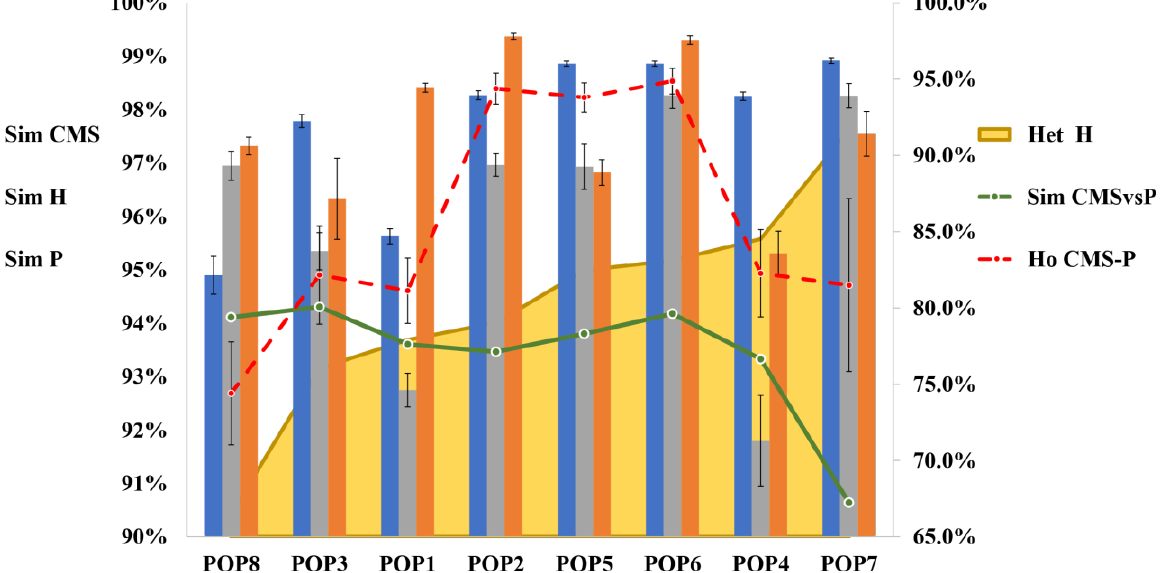
Figure 3. Graphical representation of the genetic similarity (Sim) calculated within the CMS (blue bar), H (gray bar) and P (orange bar) lines of each population (vertical scale on the left) as well as the H line heterozygosity (yellow area), genetic similarity among the CMS and P lines (green dashed line) and their average homozygosity (red dashed line) (vertical scale on the right).